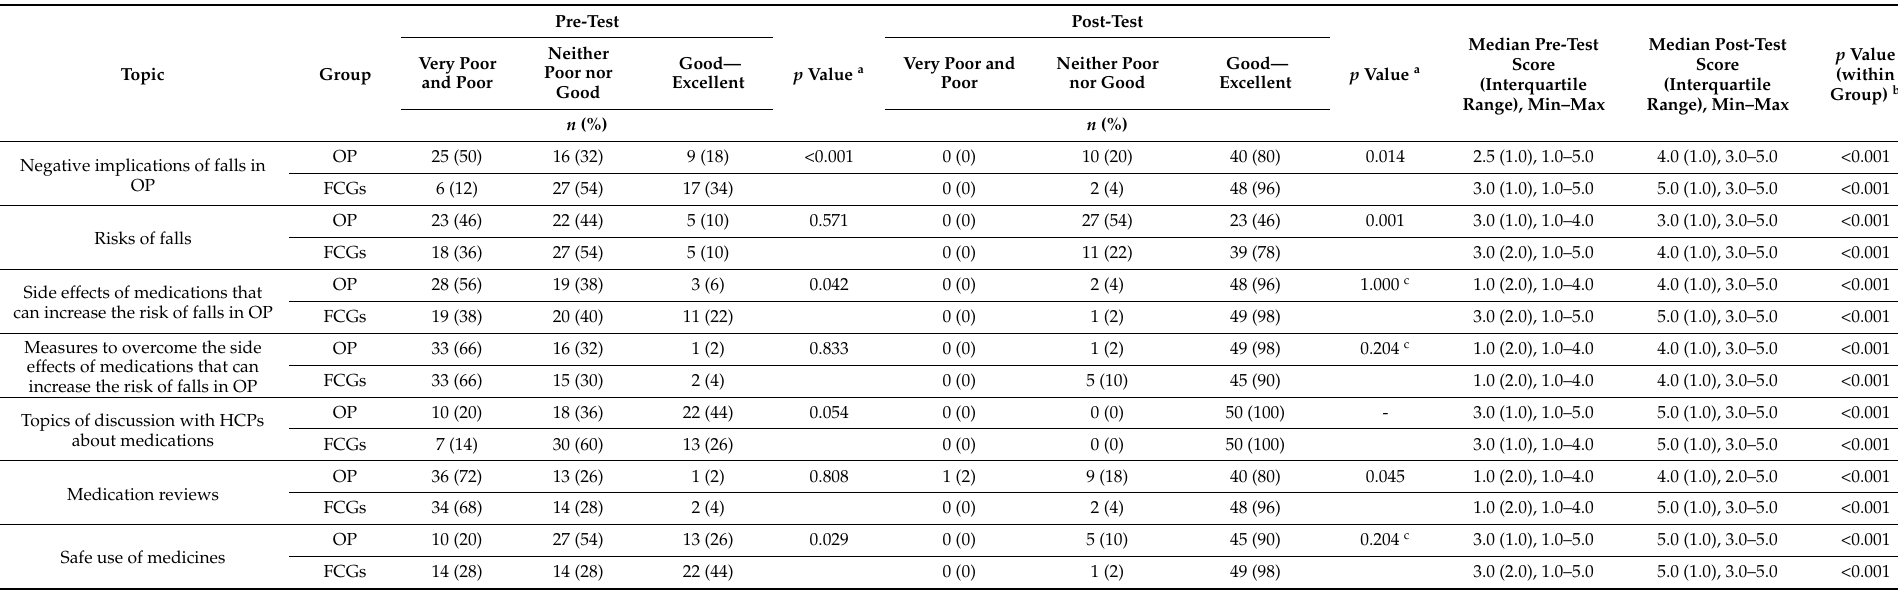
Table 5. Comparison of participants’ perceived knowledge before and after the intervention within and between groups (OP, n = 50 and FCGs, n =